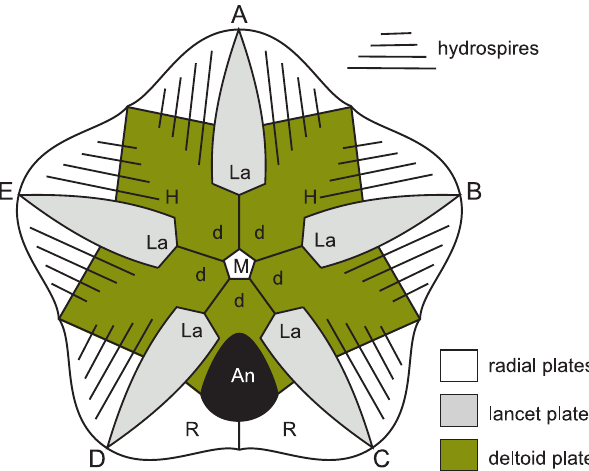
Fig. 23. Oral surface of the blastoid Codaster acutus McCoy, 1849, early Carbo niferous, England, UK, showing interpretation of oral plating. Five ambulacra (A–E) are recumbent on the lancet plates (La) with the floor plates omitted for clarity. Five deltoid plates (d) form the mouth (M) frame and share the adoral parts of the hydrospire slits (H), the aboral parts of which are in the radial plates (R). An, anus. For plate homologies see Table